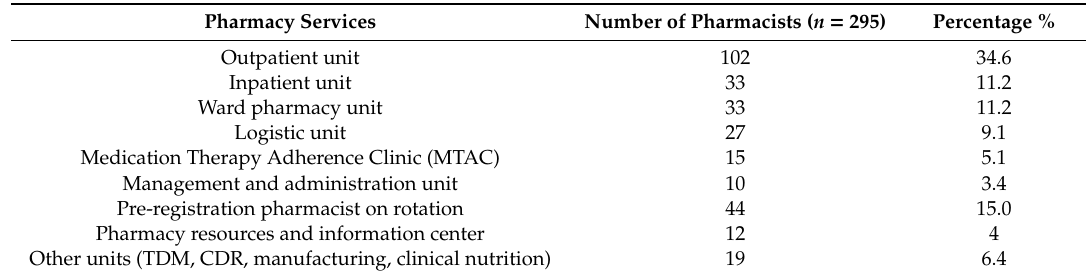
Table 1. Distribution of respondents according to the type of pharmacy settings.